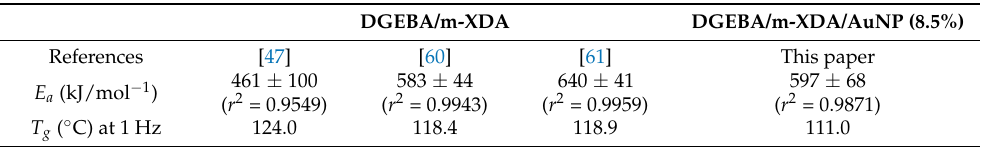
Table 7. Activation energy from T g values determined from tan δ peaks at frequencies ≤ 10 Hz and T g values measured at 1 Hz.